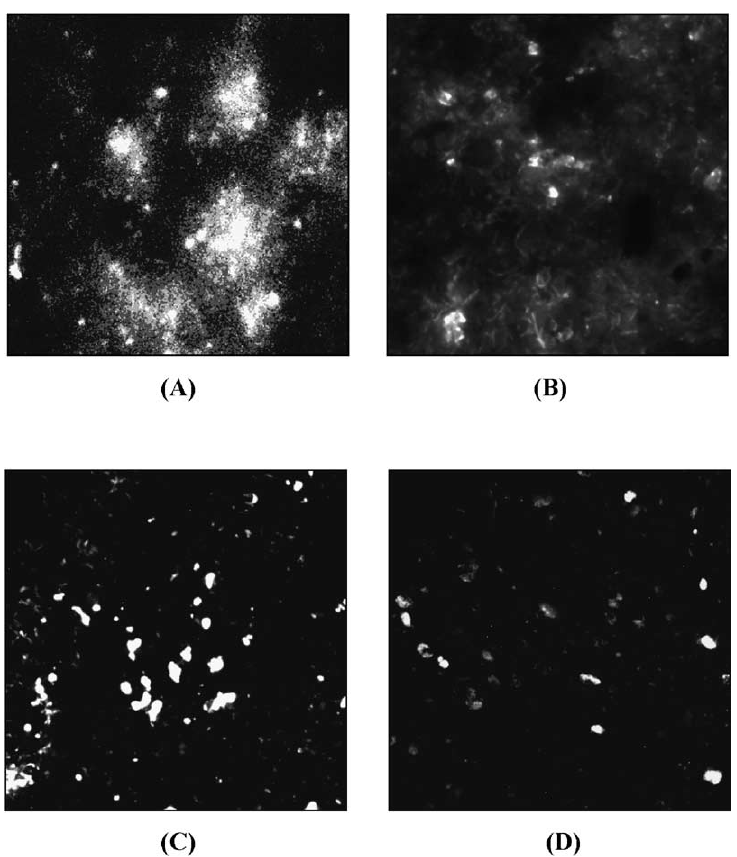
Fig. 2. Representative fluorescence microscopic images of M1, 512 × 512 pixels, 8 bits per pixel: (A) CS-LLC/Cy5.5, (B) CR-LLC/Cy5.5, (C) CS-LLC/Cy3 and (D)